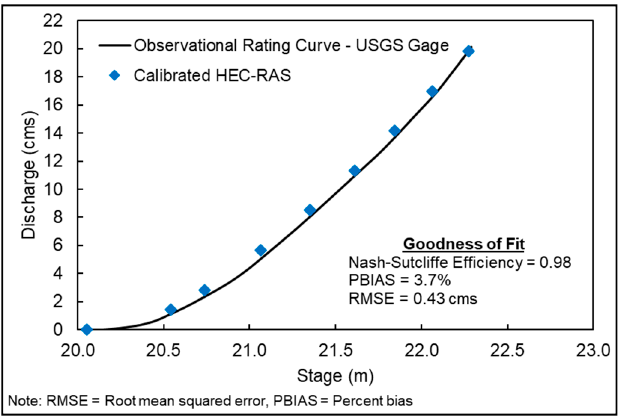
Figure 3. Observed rating curve and calibrated HEC-RAS model results at stream gage location.